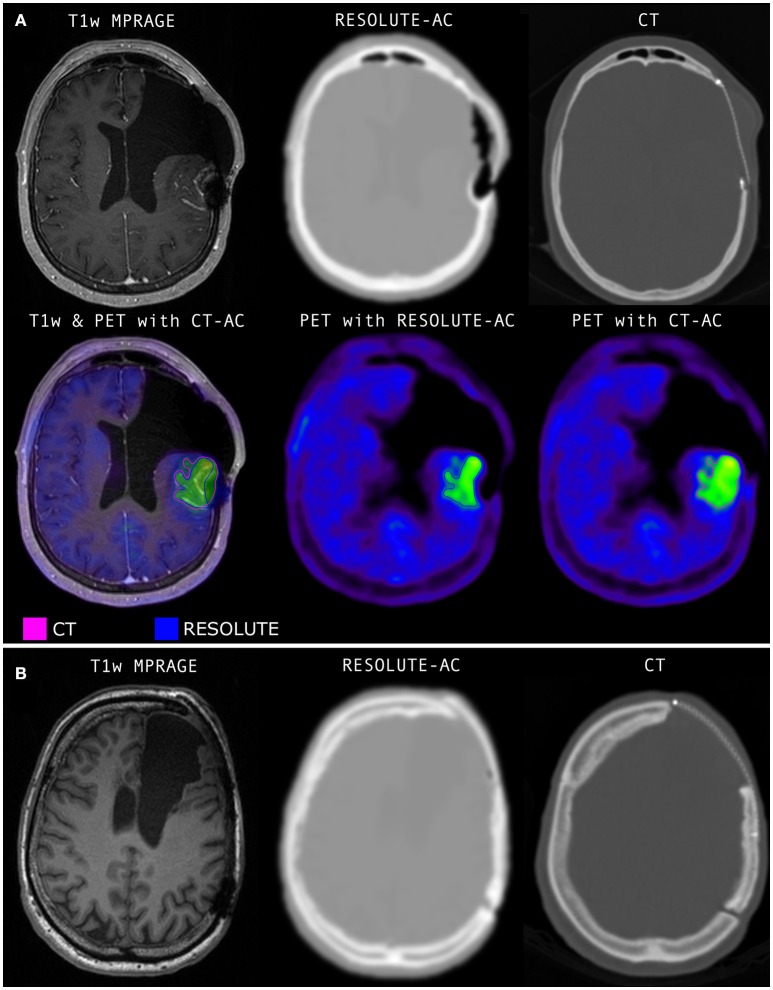
(A) The only case in the series where RESOLUTE gave clinical unacceptable results. Not included in the quantitative analyses. The titanium alloy mesh implant give rise to a cigar shaped signal void along the mesh, and a spherical void at it posterior adhesion screw. Bone is build into the lateral frontal subcutaneous tissue swelling and medially into intracranial soft tissue. The FET PET activity distribution shows a significant defect at the posterior signal void. (B) A patient with the same type of metal implant but with a minor non-significant signal void in the MR image. Notice, the CTs shown here are before resampling to PET resolution and before blurring is applied to better display the implant. The RESOLUTE attenuation map calculation can be finished in 5 min during the PET acquisition allowing for quality assurance and corrective measures, such as low dose CT of the head for attenuation correction, before the patient leaves the department.